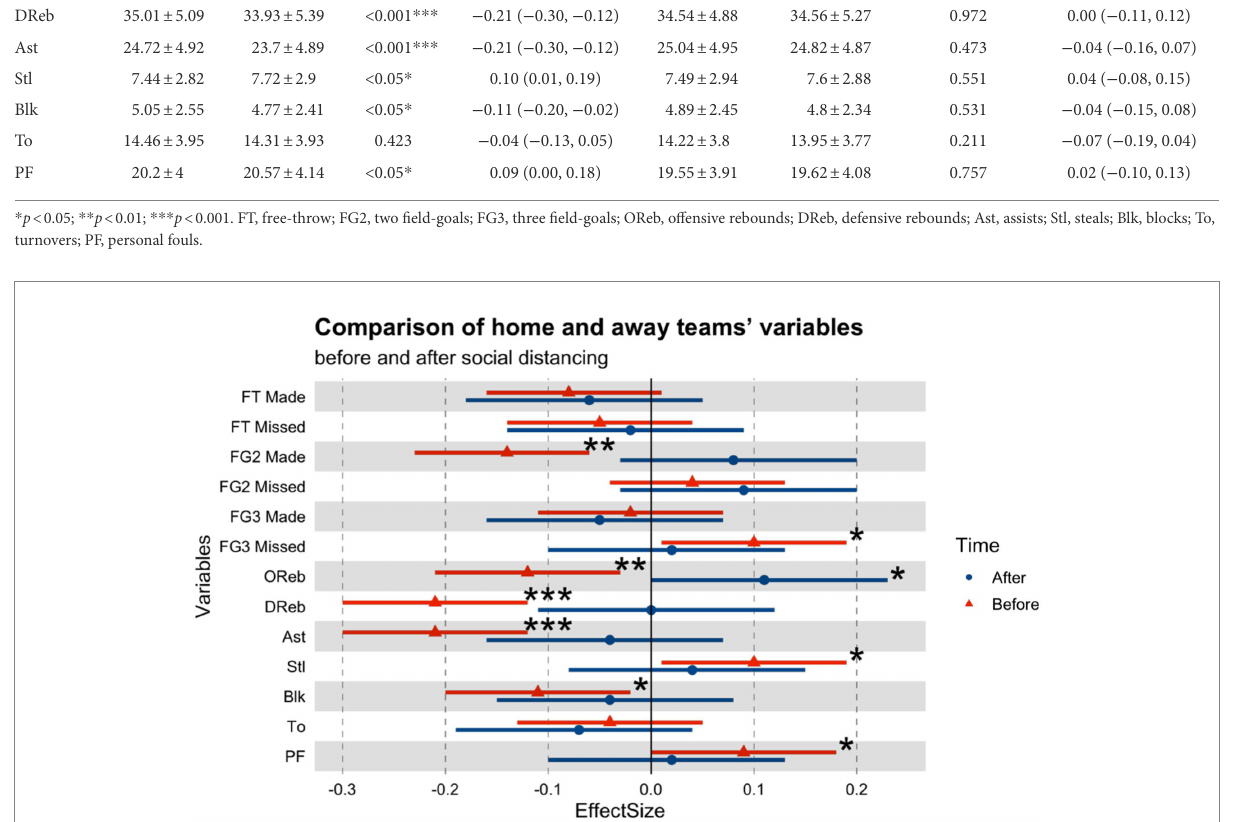
After the epidemic, nine variables were independently statistically significant winning factors by univariate binary logistic regression model and still statistically significant after multivariable analysis. These variables included both free-throws